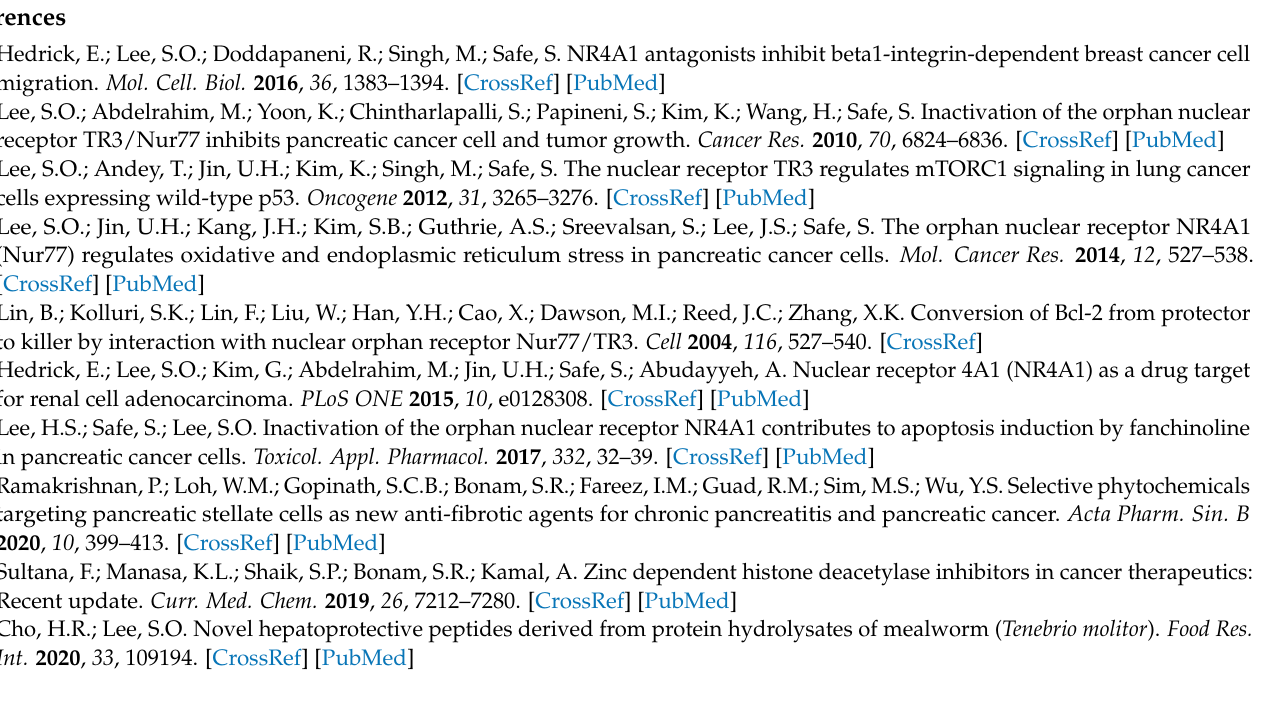
Supplementary Materials: Figure S1: The UV-vis absorption, HPLC spectrum and chemical structure of BCA isolated from B. papyrifera roots, Figure S2: Effect of BCA on luciferase activity in MIaPaCa-2 cells transfected with Gal4-RE-Luc/C-terminal deletion Gal4-NR4A1 chimera (Gal4-NR4A1-AB), Figure S3: Effects of BCA on cell growth in various cancer cell lines expressing NR4A1, Table S1: Chromatographic conditions for